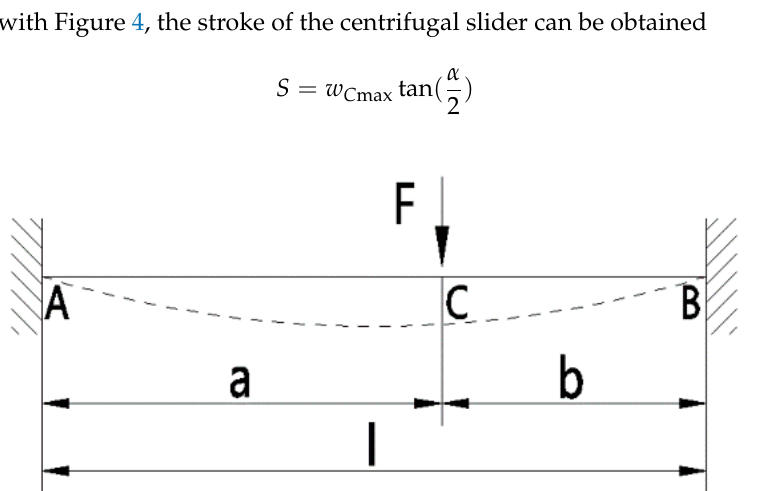
Figure 6. The schematic diagram of elastic-beam deflection analysis.